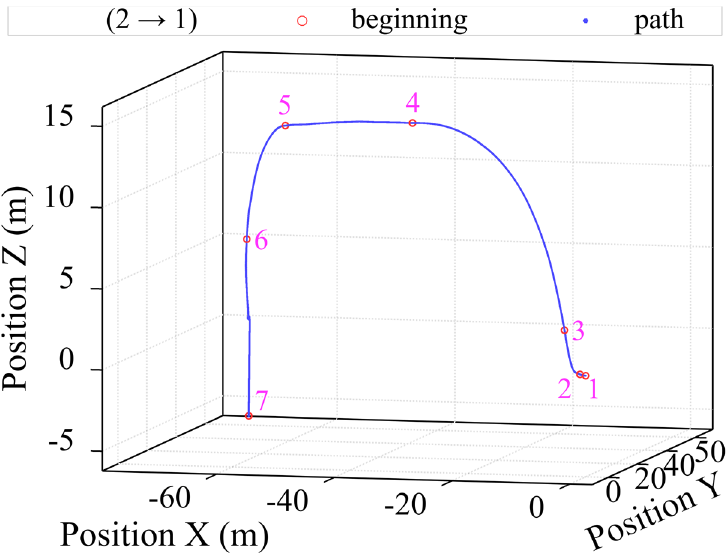
Figure 4. Container crane spreader trajectory in one handling cycle.